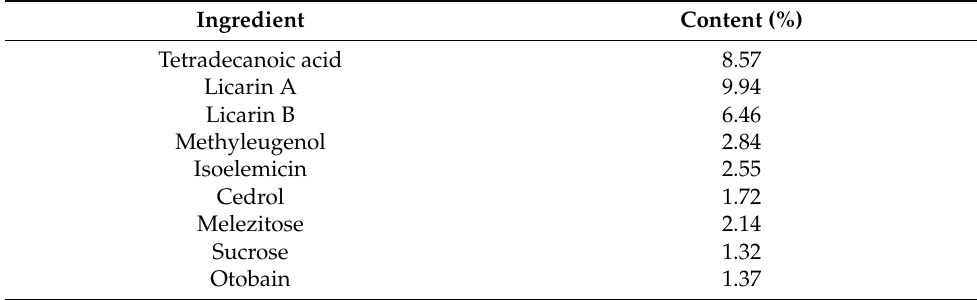
Table 1. The main ingredients of Myristica fragrans extracts